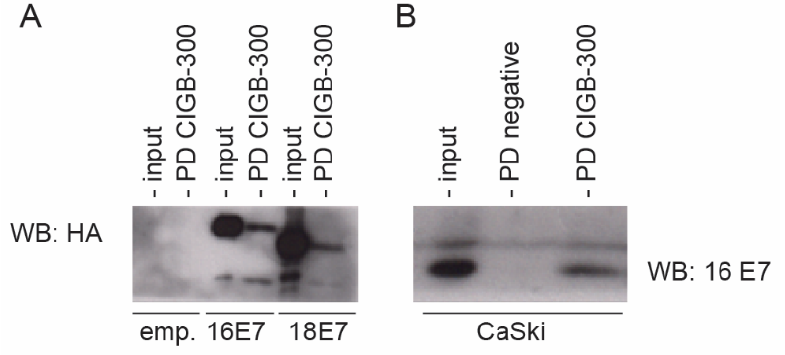
Figure 2. In vivo interaction of CIGB-300 with E7 protein. FLAG-HA-tagged HPV-16 E7 was over- expressed in HEK293 ( A ) and CaSki ( B ) cells. The cells were treated with biotin-tagged CIGB- 300 (200 µ M) for 30 min and then processed as described in “Materials and Methods”. CIGB- 300-interacting proteins were separated by SDS-PAGE and immunoblotted using anti-HA-tag and anti-HPV-16 E7 antibodies for HEK293 and CaSki, respectively. PD: pull-down fractions; NC: negative control (cells incubated with the empty vector). Results are representative of three independent experi- ments.